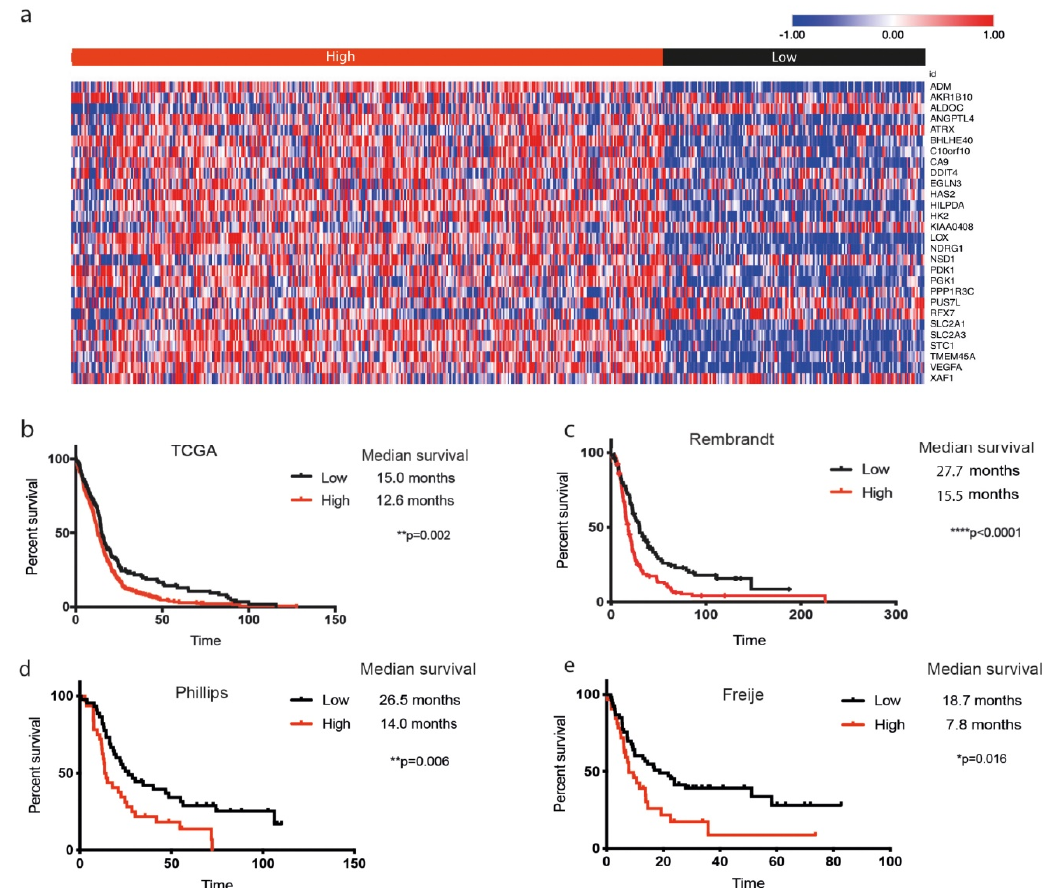
Figure 3 . Correlation of the hypoxia signature with survival of high-grade glioma patients. ( a ) Expression of the hypoxia gene signature (z-score) across patients from TCGA database ( n = 528), segregated by high and low expression of the signature; ( b – e ) Kaplan–Meier survival curves corresponding with high (red) or low (black) expression of the hypoxia signature in ( b ) TCGA ( n = 528), ( c ) Rembrandt ( n = 267), ( d ) Phillips ( n = 100), and ( e ) Freije ( n = 85) databases .